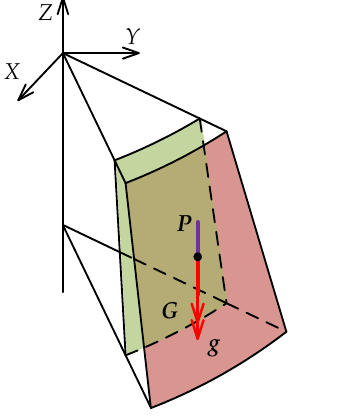
Figure 8. The force and acceleration components of free-falling particles.